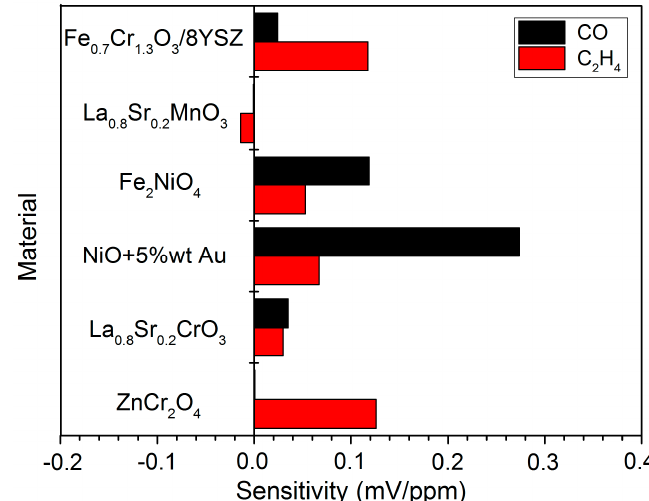
Figure 4. Sensor sensitivity (mV/ppm) to C 2 H 4 (red) and CO (black) individually for several materials used as working electrode. The sensor sensitivity is defined as V cell /analyte concentration (mV/ppm) in the linear range of sensor response and calculated as a linear regression. ZnCr 2 O 4 and Fe 2 NiO 4 are evaluated in the range 200–1000 ppm, while the rest of the materials (Fe 0.7 Cr 1.3 O 3 , LSC, LSM, and NiO+5%wt Au) are evaluated in the range 50–200